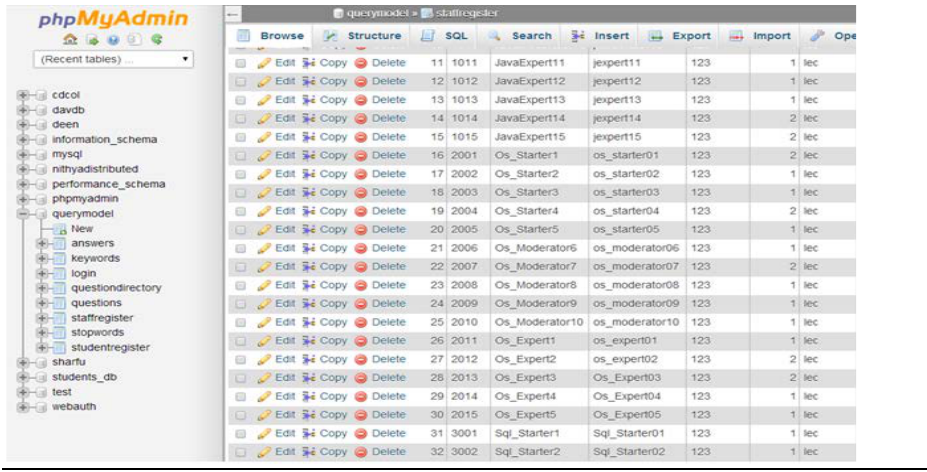
Figure 2 . Screenshot of expert registry.